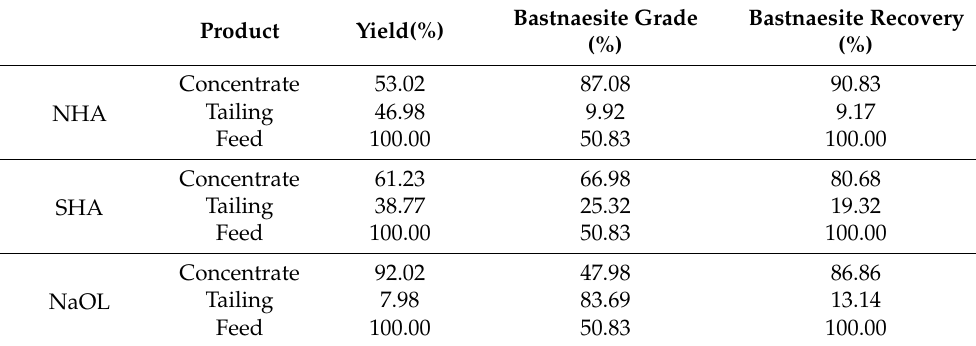
Table 3. The results of flotation separation of artificial mixed ore.